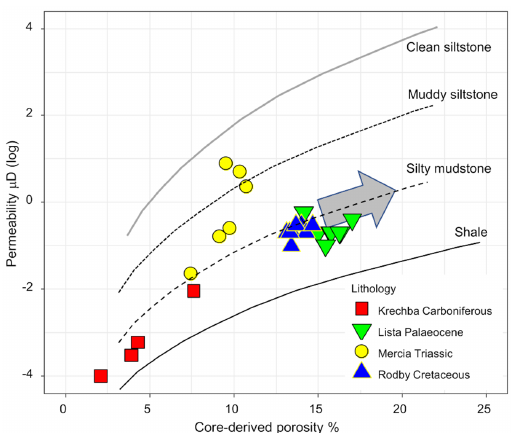
Figure 16. Permeability, in microDarcies, and percentage porosity derived from the mercury intrusion data from the Lista and Rodby Shales compared to equivalent data from the Carboniferous top-seals at the Krechba InSalah CCS site in Algeria [36] and from Upper Triassic Mercia Mudstone top-seals to potential Sherwood Sandstone CCS reservoirs, UKCS [37]. These four shales have been compared to published porosity and permeability trends for di ff erent fine-grained clastic lithologies [38], modelled as shale, silty mudstone, muddy siltstone and clean siltstone. The Palaeocene Lista Shale has a slightly higher porosity than the Cretaceous Rodby Shale, probably as it is younger and has not had su ffi cient time to compact. Although the Lista and Rodby Shales have relatively high porosity, they lie on a rationale porosity-permeability trajectory largely between silty mudstone and shale. The Lista and Rodby Shales have a higher porosity and permeability than the Carboniferous top-seal at the Krechba site because they are younger and have not been as hot resulting in less compaction and mineral diagenesis. Some of the Mercia Mudstone samples are silt rich with the consequent poor sorting leading to higher permeability but lower porosity than the Lista and Rodby mudstones. This diagram can be used to help predict the consequence of porosity-enhancement, due to CO 2 -induced mineral dissolution, on permeability (see grey